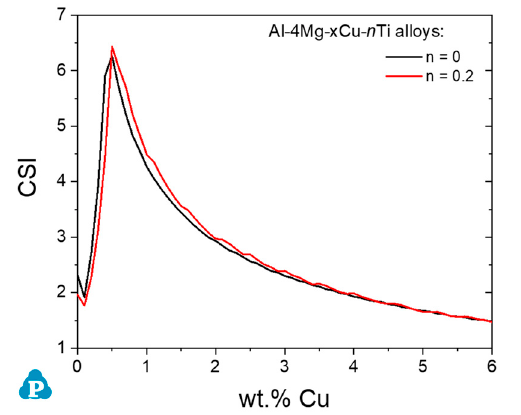
Figure 11. Calculated CSI for a series of Al-4Mg-xCu- n Ti ( n = 0 and 0.2 wt%) alloys.